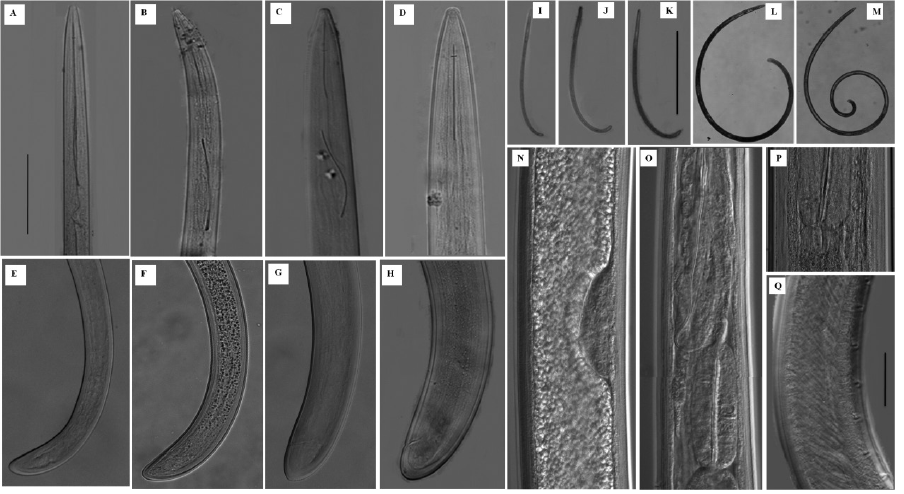
Figure 1. Longidorus cheni sp. n. Juveniles : A–C Anterior region of first-, second- and third-stage E–G Poste- rior end of first-, second- and third-stage I–K Habitus of first-, second- and third-stage juvenile N developing gonad in a second stage juvenile. Female : D Anterior end H Tail L Habitus O Pharyngeal bulb region P Cardia